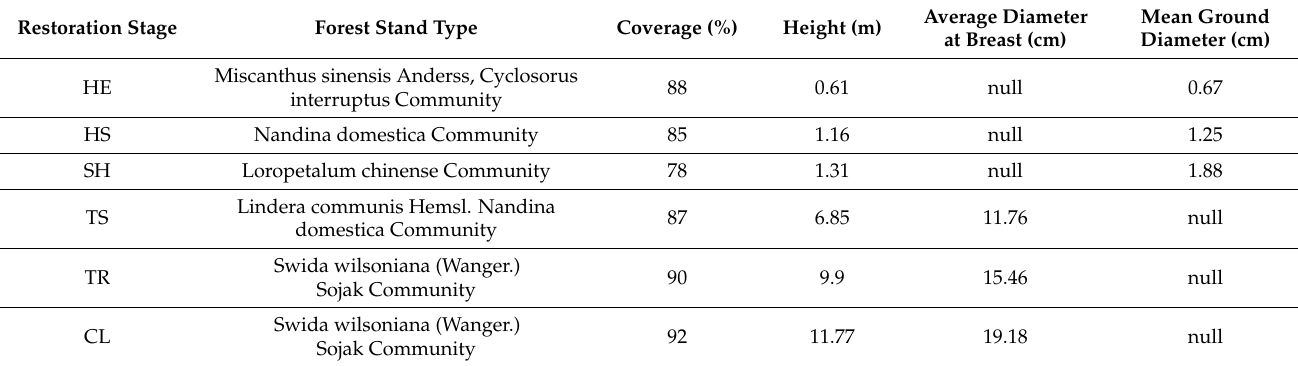
Table 2. Basic information on sample sites. CL—ultimate stage, TR—tree stage, TS—tree and shrub transition stage, SH—shrub stage, HS—grass and shrub transition stage, HE—herbaceous